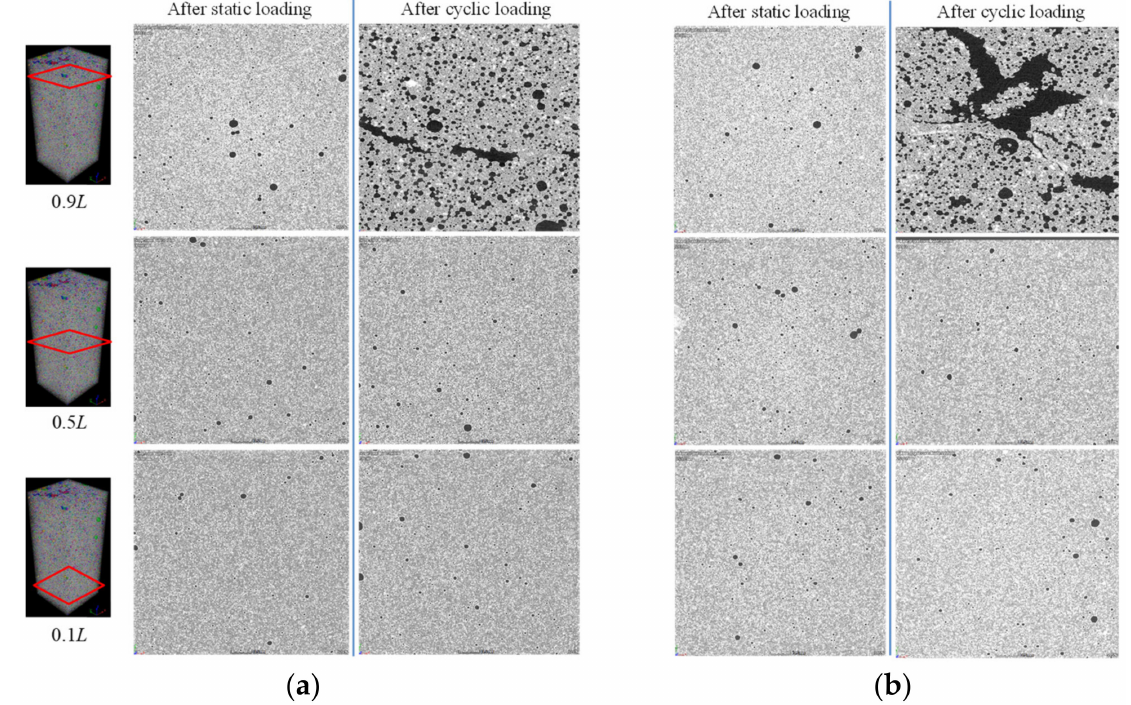
Figure 11. Comparison of cross-sectional greyscales of the FC9 specimens after static and cyclic loading tests: ( a ) R = 0.2, ( b ) R =